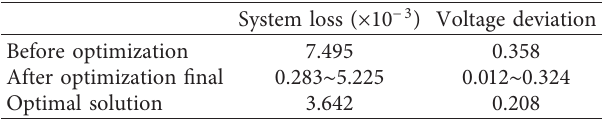
Figure 11: Real-time output value of each equipment under the priority of cooling and heating load. Table 10: Comparison of optimization index.